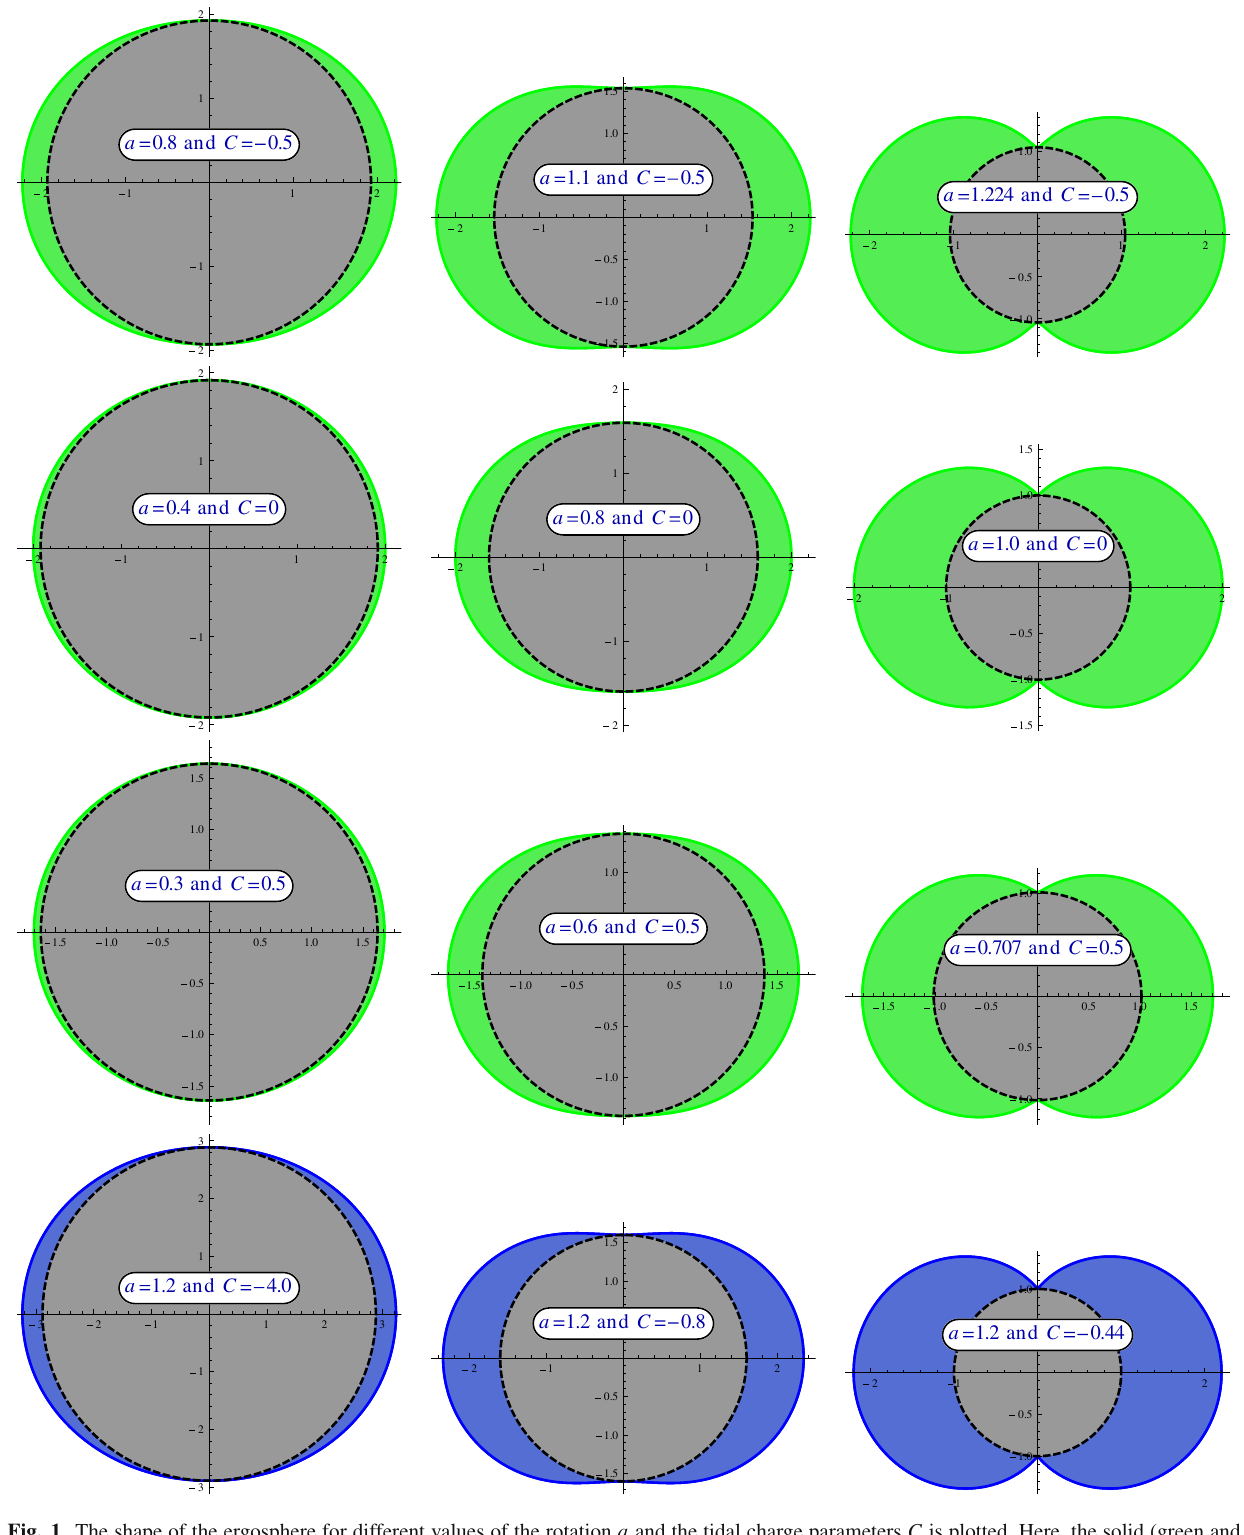
Fig. 1 The shape of the ergosphere for different values of the rotation a and the tidal charge parameters C is plotted. Here, the solid (green and blue) lines represent the SLS, the dashed (black) lines represent the EH and we keep the value of the mass parameter M =